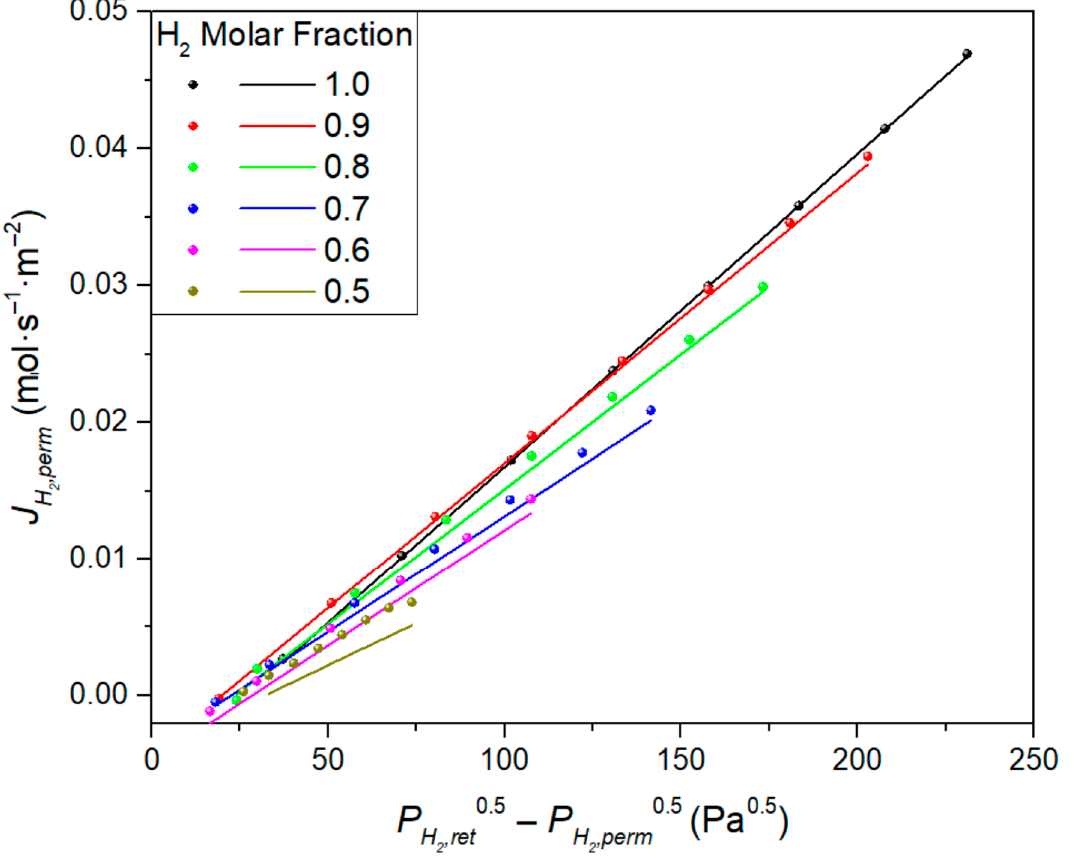
Figure 9. Experimental (symbols) and predicted (lines) H 2 permeate fluxes at a constant temperature ( T = 375 °C) but different pressures and H 2 molar fractions in the feed stream (out–in configuration).